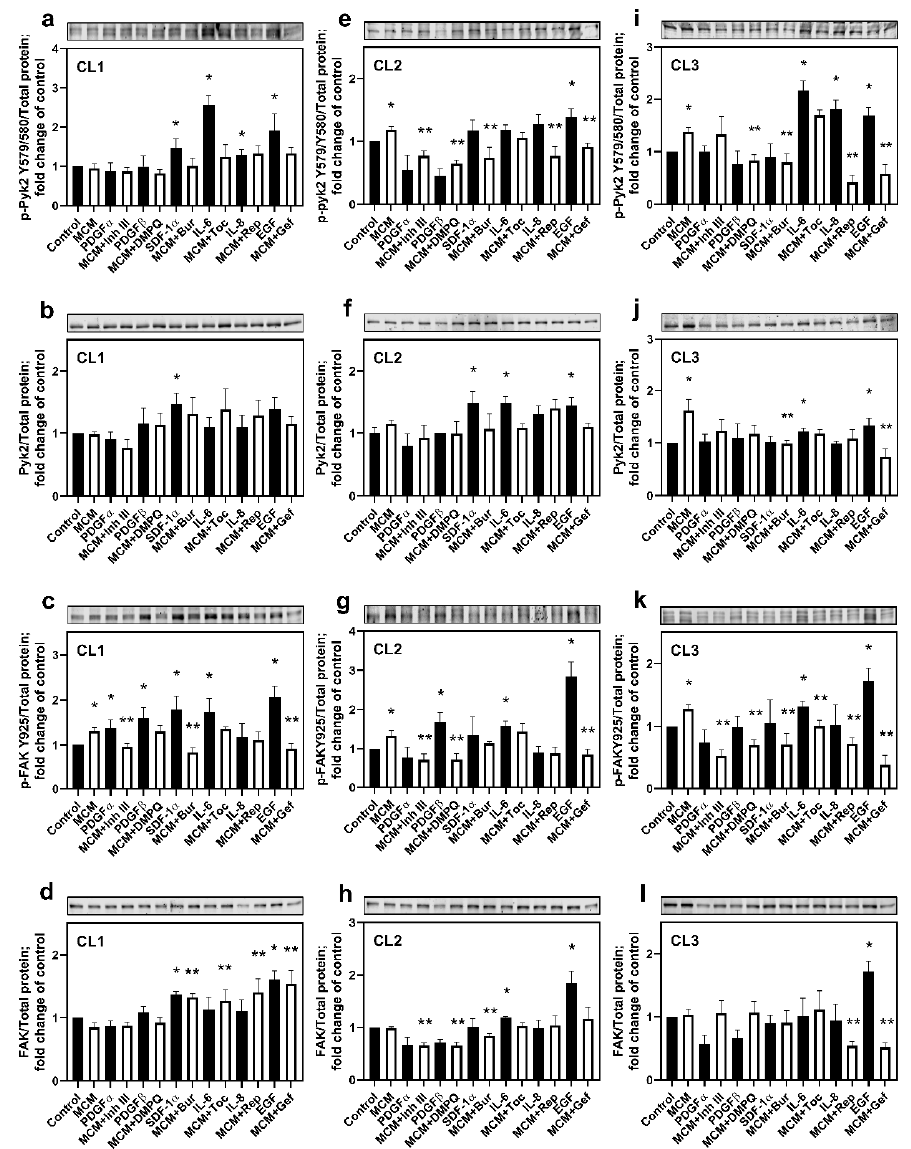
Figure 2. Cytokines and chemokines released by microglia upregulate Pyk2 and FAK protein phosphorylation in human glioma cells. Representative western blots and quantitative results for total and phosphorylated Pyk2 (Y579/580) and FAK (Y925) are presented for the cell lines CL1 ( a – d ), CL2 ( e – h ), and CL3 ( i – l ). The degree of phosphorylation was calculated as the ratio of phosphorylated Pyk2 or FAK to the total loaded protein and normalized to the control for each kinase. Total protein-stained membranes are provided in Figure S5. The values are shown as means ± SD for 3–6 experiments per group. * p < 0.05 vs. control; ** p < 0.05 vs. MCM. MCM, microglia-conditioned medium; Inh III, inhibitor III; Bur, burixafor; Toc, tocilizumab; Rep, reparixin; and Gef, gefitinib. Figure 2g demonstrates that MCM also upregulated FAK phosphorylation in CL2 compared with control (by 34%, p < 0.05). Similarly, PDFG β , IL-6, and EGF increased p-